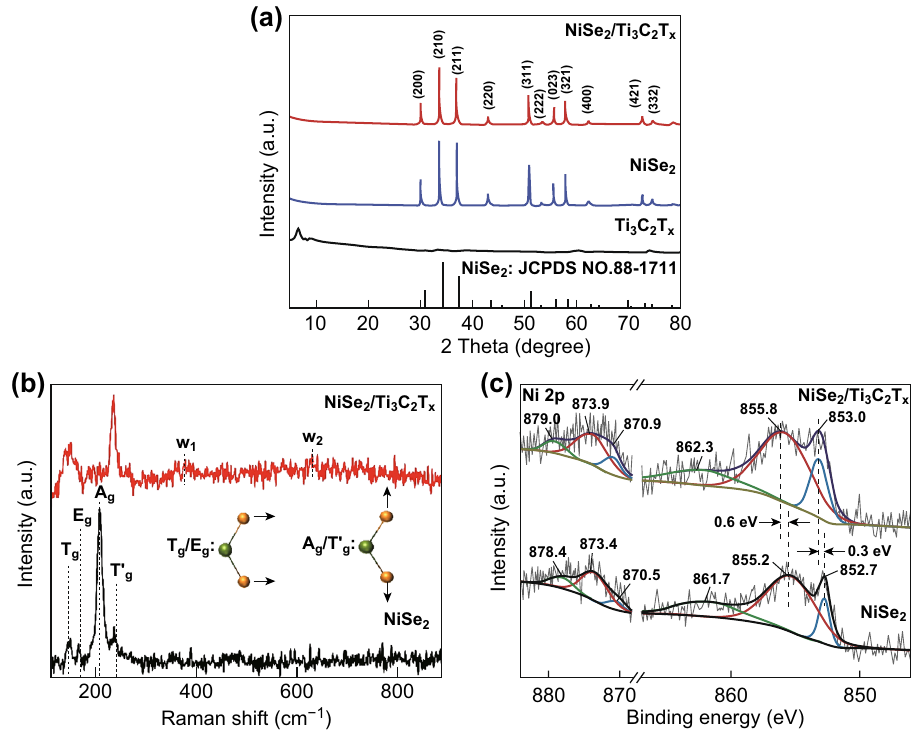
Fig. 2 a XRD patterns of unmodified NiSe 2 and NiSe 2 /Ti 3 C 2 T x hybrid. b Comparison of Raman spectra for NiSe 2 and NiSe 2 /Ti 3 C 2 T x hybrid, and the inset is atom schematic of NiSe 2 . (The green ball is Ni atom, and the yellow ball is Se atom.) c Ni 2 p XPS spectra of unmodified NiSe 2 and NiSe 2 /Ti 3 C 2 T x